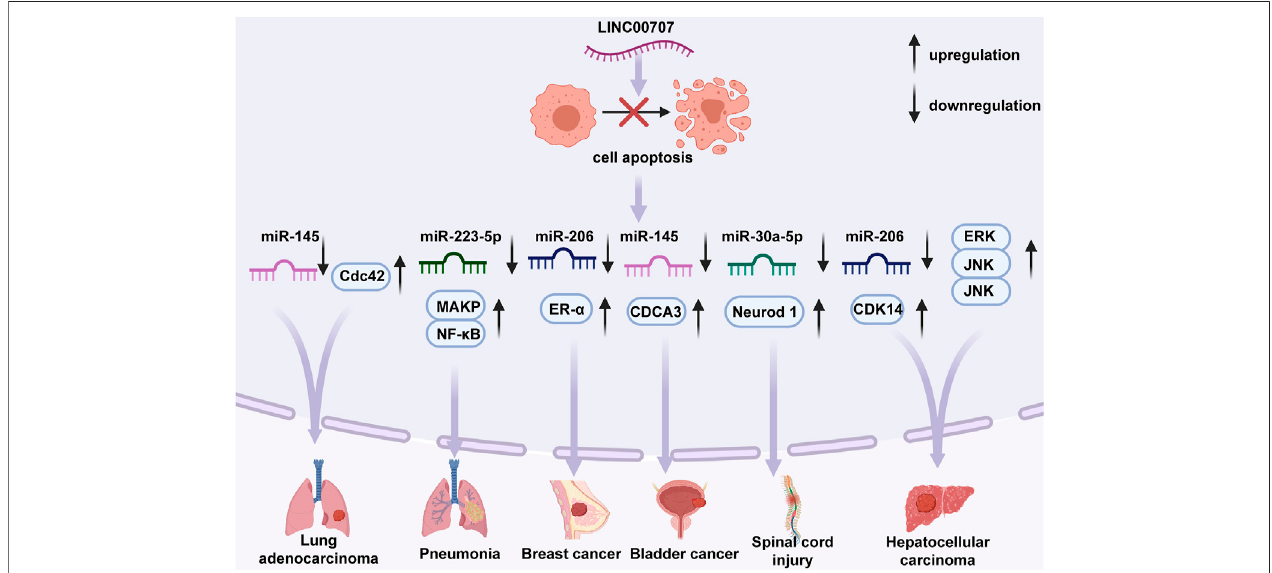
FIGURE 3| Regulative functions of LINC00707 in the apoptotic mechanisms of certain cell types. In lung adenocarcinoma, LINC00707 suppresses cell apoptosis by activating expression of Cdc42 or inhibiting expression of miR-145. In pneumonia, LINC00707 binds to miR-223-5p and regulates p38 mitogen-activated protein kinase (MAPK), and nuclear factor- κ B (NF- κ B) signaling pathways. In breast cancer, LINC00707 suppresses miR-206 expression and upregulates ESR1 expression. In bladdercancer,LINC00707combineswithmiR-145andaffectsexpressionofCDCA3.Inhepatocellularcarcinoma,LINC00707mediatesactivityoftheERK/JNK/ AKT pathway or interacts with miR-206 to regulate expression of CDK14. In spinal cord injury, LINC00707 binds to miR-30a-5p and inhibits expression of Neurod 1.